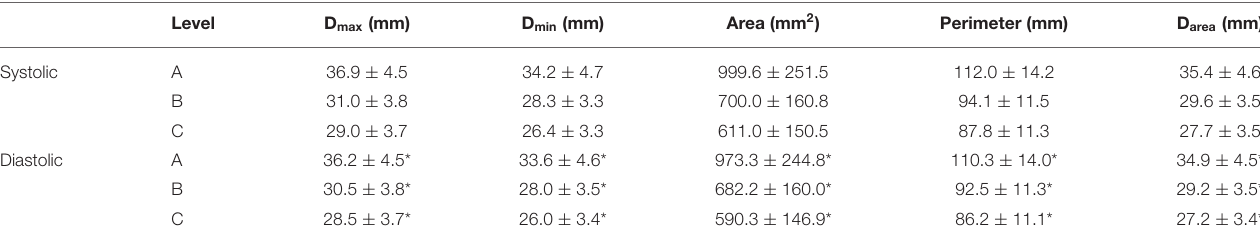
TABLE 2 | The aortic dimensional measurements during the cardiac cycle at different